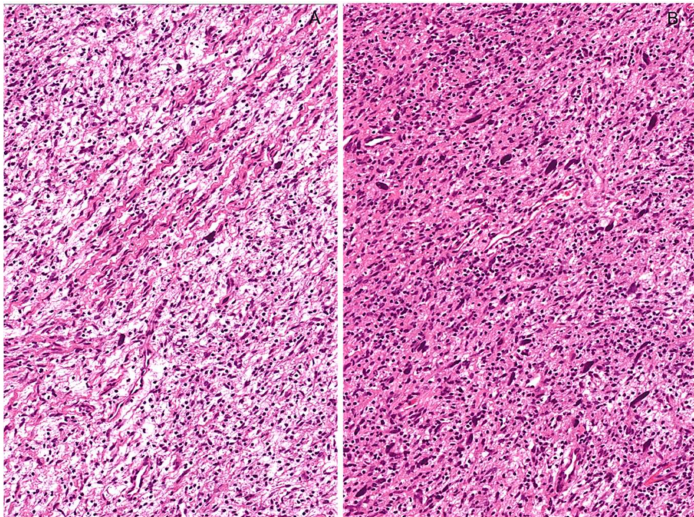
Figure 7. Neurofibroma with cytological atypia. Low ( A ) and higher ( B ) magnifications showing diffuse nuclear atypia; hypercellularity, mitoses, and necrosis are not observed.